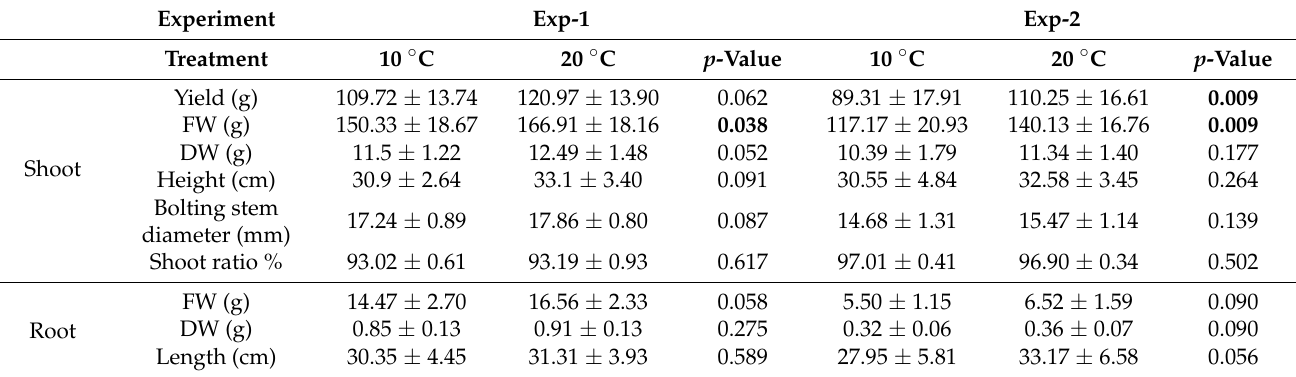
Table 1. Yield, shoot and root fresh weight (FW), shoot and root dry weight (DW), shoot height, bolting stem diameter, root length and shoot ratio of Chinese broccoli under different root temperatures in Exp-1 and Exp-2. Significant differences ( p < 0.05) were indicated in bold.